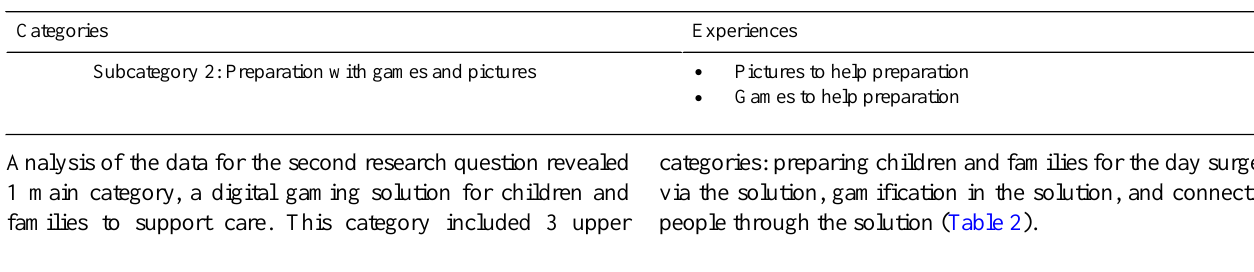
Table 2. Parental needs for a gamification solution in the day surgery